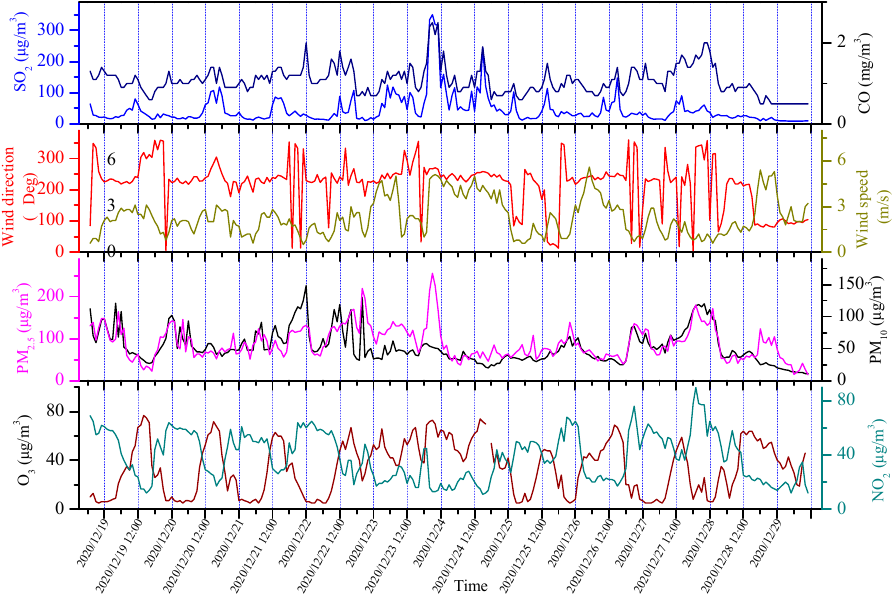
Figure 2. Temporal profiles of gaseous pollutants (O 3 , SO 2 , CO, and NO 2 ), wind direction, wind speed, and PM 2.5 and PM 10 mass concentrations.